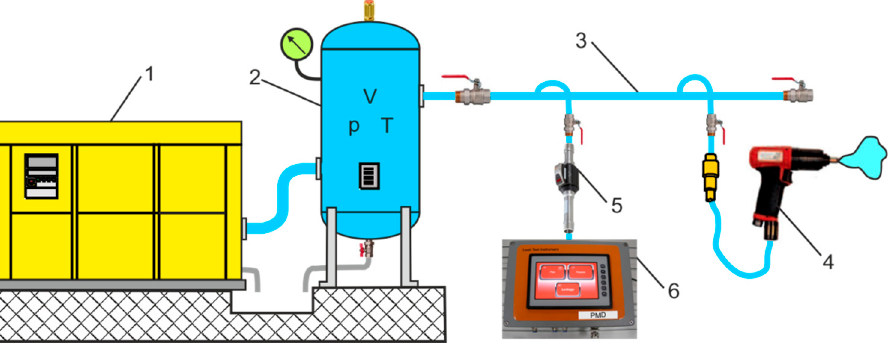
Figure 5. Schematic diagram of CAS: 1—compressor, 2—stand-alone receiver tank, 3—pipeline system, 4—pneumatic tool, 5- measuring instrument, 6—PMD.